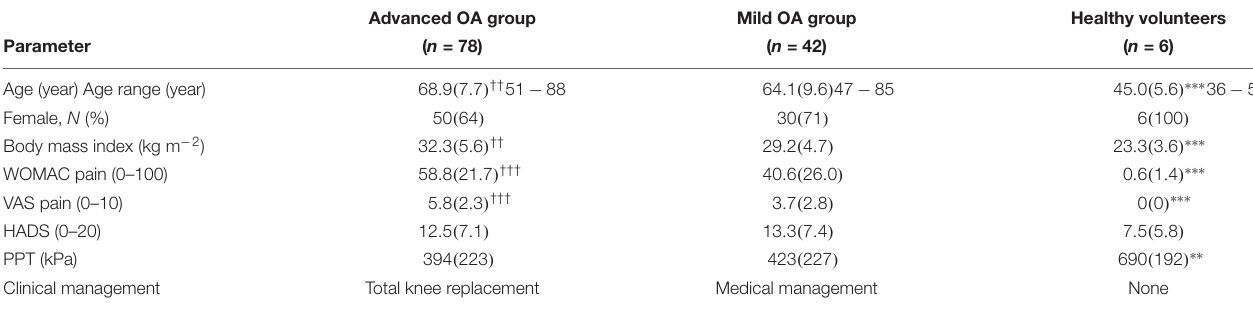
TABLE 1 | Study demographics. Advanced OA group Mild OA group